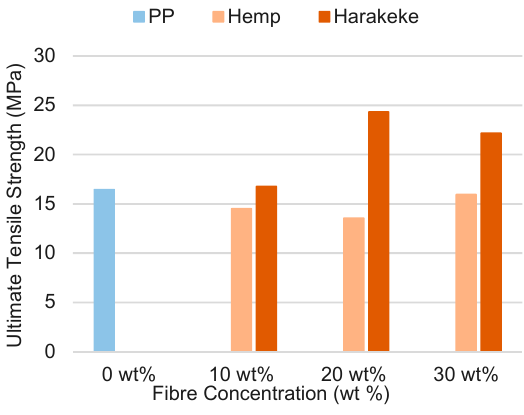
Figure 10. Ultimate tensile strength of FDM printed dog bone specimens